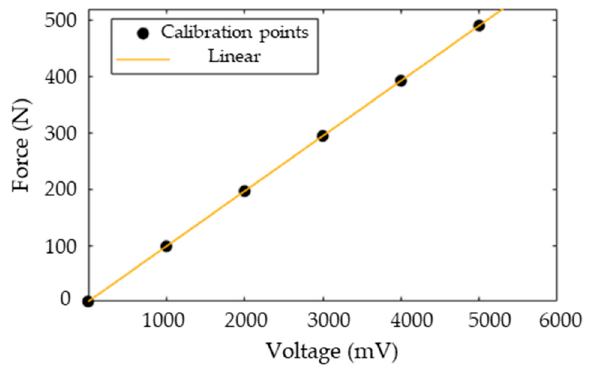
Figure 7. Voltage–force relationship for pulling force load cell.